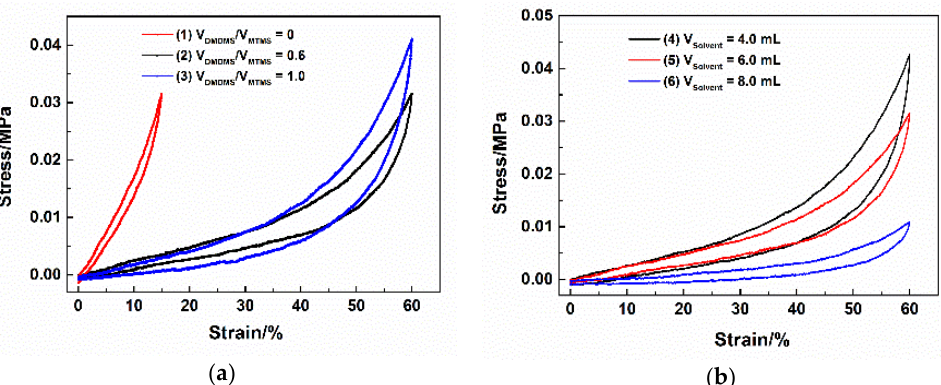
Figure 3. ( a ) Stress-strain curves of flexible MSQ aerogels (without surface modification) prepared with varied volume ratios of co-precursor; ( b ) Stress-strain curves of flexible MSQ aerogels (without surface modification) prepared with varied solvent volumes.